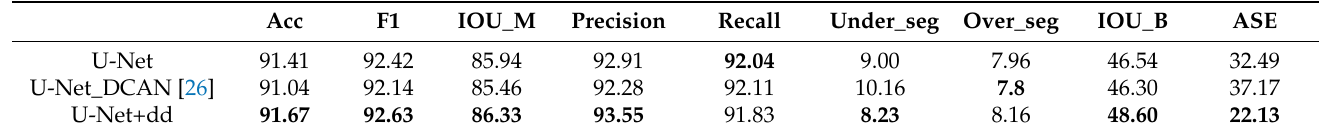
Figure 8. Difference of decoders with/without a boundary mask fusion block (BMFB); ( a ) the decoder of U-Net_DCAN [26]; and ( b ) the decoder of U-Net+dd. Table 4. Comparison of different models with/without a boundary mask fusion block (BMFB). The bold number means the best